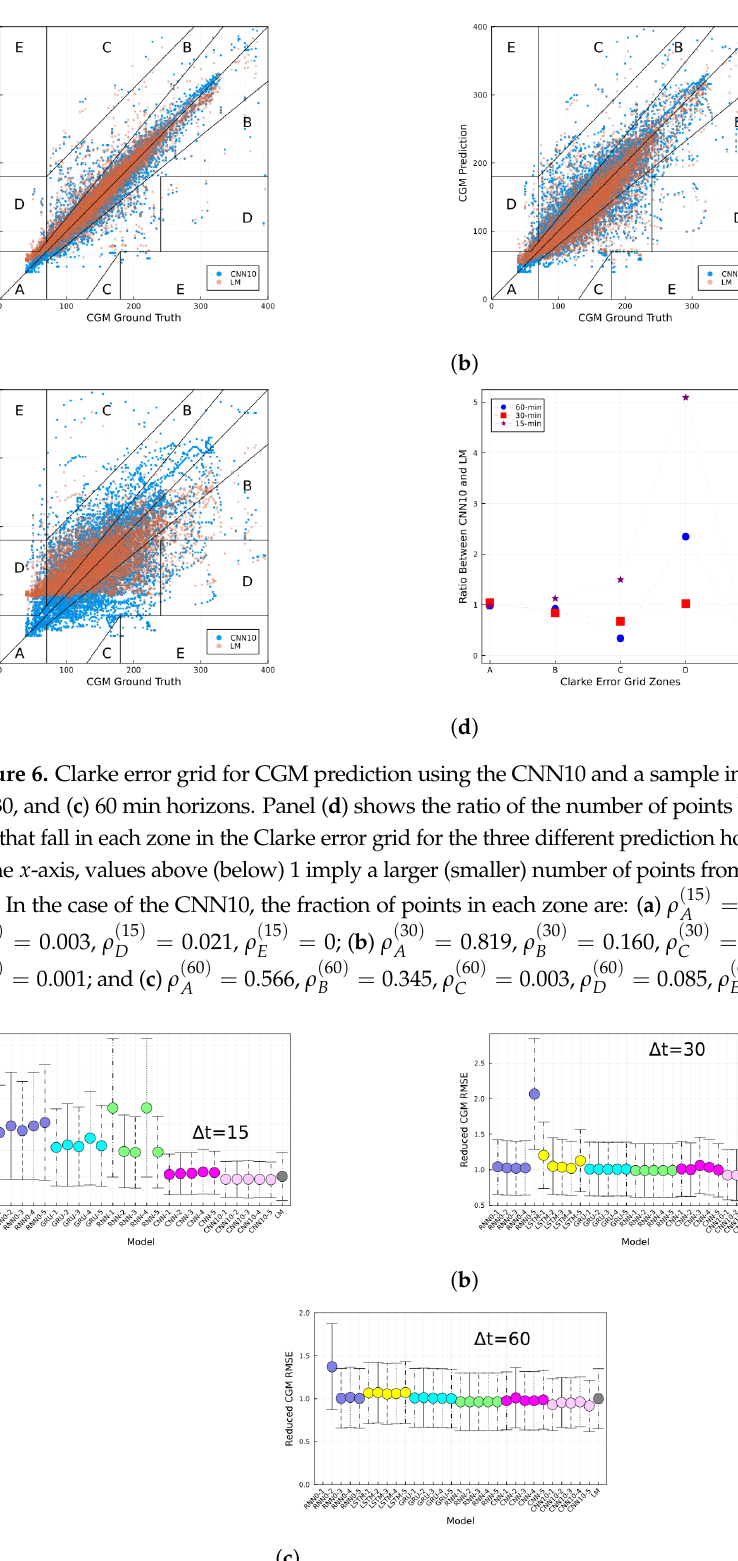
Figure 7. CGM prediction root mean squared error reduced by the LM prediction for ( a ) 15, ( b ) 30, and ( c ) 60 min horizons, and for different architectures. Each panels shows the RMSE for different architectures specified in the x -axis and for the last-measurement prediction (LM). The RMSE of the given model is divided by the RMSE of the LM. Models below (above) 1 perform better (worse) than the LM